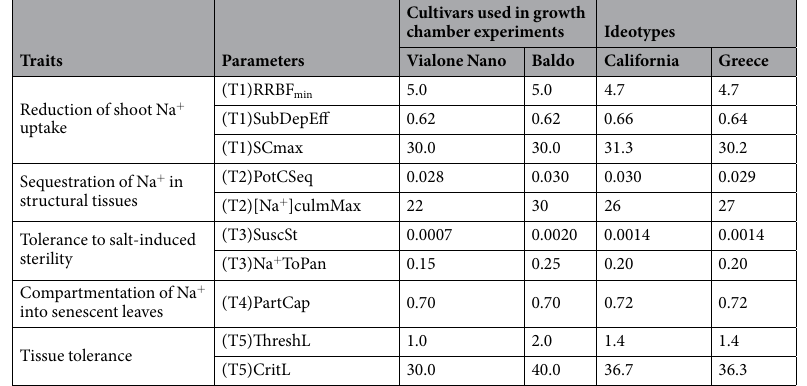
Table 2. Plant traits involved with tolerance to salinity and corresponding model parameters (acronym meanings and units are provided in Table 1) for the two rice cultivars for which growth chamber experiments were performed and for the ideotypes defined for the sites in California and